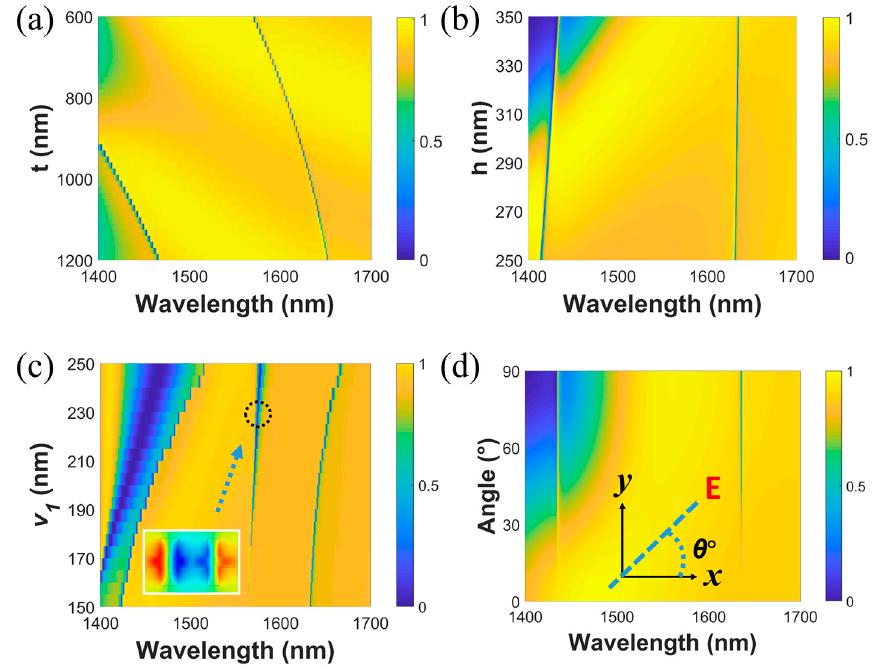
Figure 4. ( a ) Transmission spectra with varying substrate thickness (t). ( b ) Transmission spectra with varying dielectric height (h). ( c ) The calculated transmission spectra when v 1 changes from 150 nm to 250 nm. The inset is the out-of-plane magnetic field component for the new resonance when v 1 is 230 nm. ( d ) Transmission spectra with varying incident polarization angles from 0° to 90°.